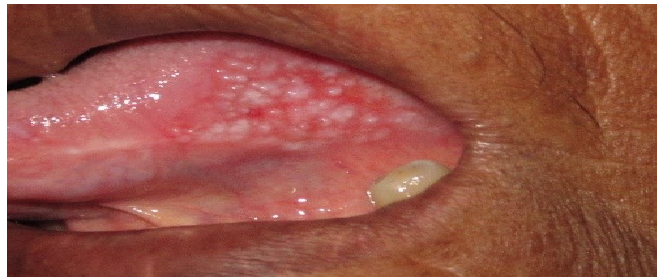
Figure 8. RGB image of lateral tongue.